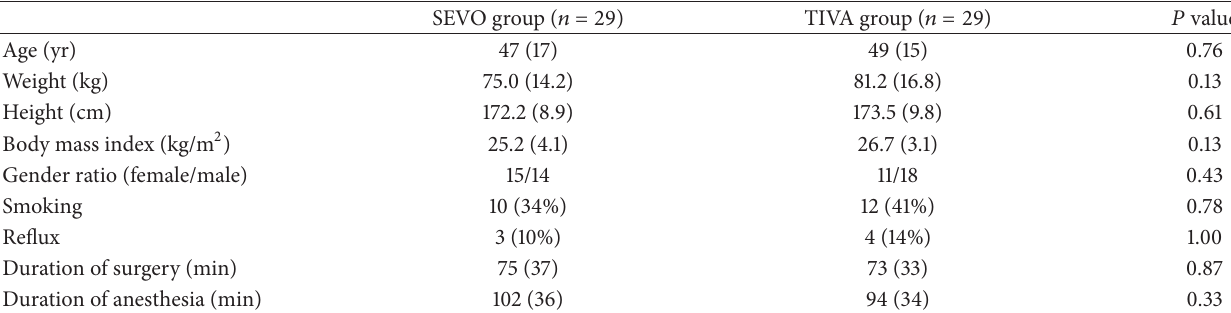
Table 1: Demographic data, duration of surgery, and